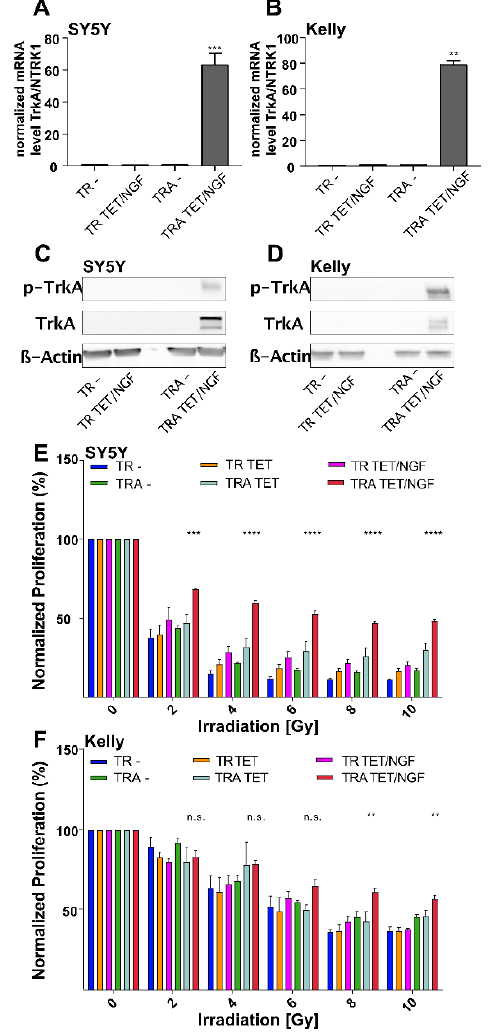
Figure 1. Inducible expression and activation of TrkA/NTRK1 in SY5Y-TRA and Kelly-TRA cells and the impact on proliferation upon ionizing radiation. ( A , B ) SY5Y and Kelly cells were engineered to express TrkA/NTRK1 upon addition of tetracycline (TET). The suffix “-TR” indicates the presence of the TET-repressor only, while the suffix “-TRA” refers to cells harboring the TR and the TET- responsive element controlling TrkA/NTRK1 expression. Shown are mRNA levels of TrkA/NTRK1 in the cell lines indicated. Data were obtained by qPCR and normalized to the expression of the house keeping gene, GAPDH ( n = 3 from three independent experiments). ( C , D ) Western blot showing protein expression of TrkA/NTRK1 (labelled “TrkA”) as well as TrkA/NTRK1 activation (indicated by receptor phosphorylation, labelled “p-TrkA”). TrkA/NTRK1 activation is only observed in SY5Y-TRA and Kelly-TRA cells upon addition of the TrkA/NTRK1-ligand, NGF. Original Western Blot data are shown in Supplementary Figure S1 ( E , F ) TrkA/NTRK1 activation results in significantly higher cell proliferation upon IR compared to parental cells and controls. Asterisks indicate signif- icant differences between irradiated cells with and without TrkA/NTRK1 activation as indicated (**** = p < 0.0001, *** = p < 0.001, ** = p < 0.01). Irradiation was performed at different dose intensities (2, 4, 6, 8 or 10 Gy). Proliferation was evaluated by MTT assay after 96 h. Error bars show the SEM from three independent